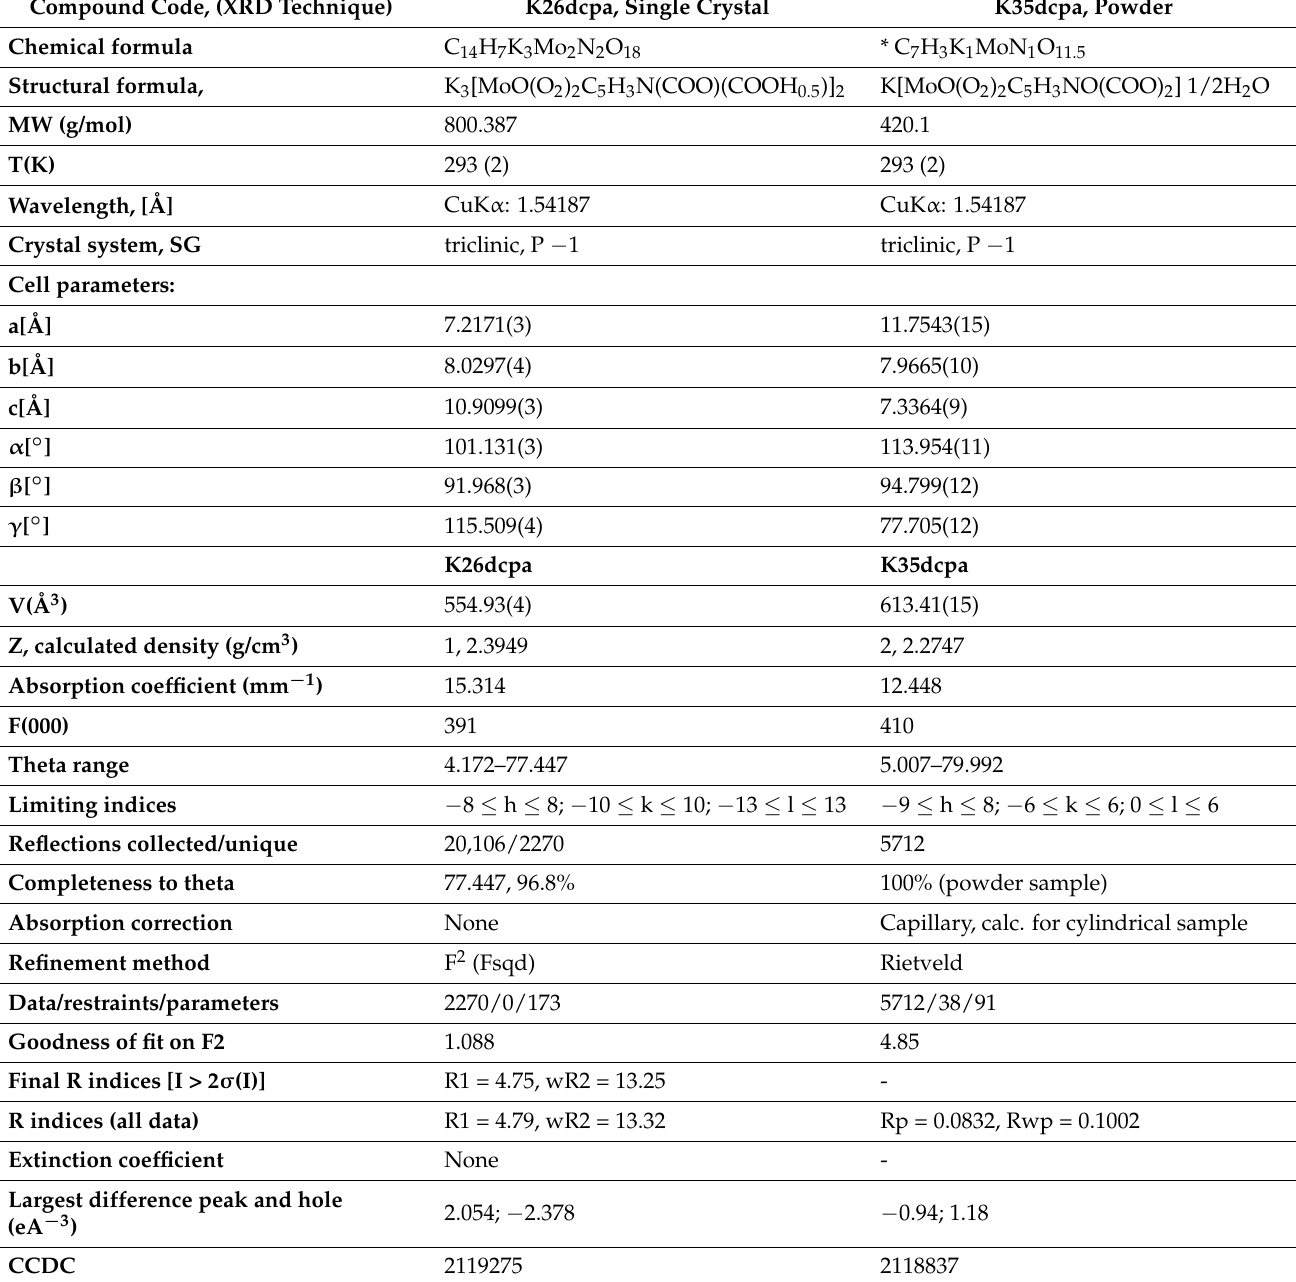
Table 1. Summary of crystal data of the investigated